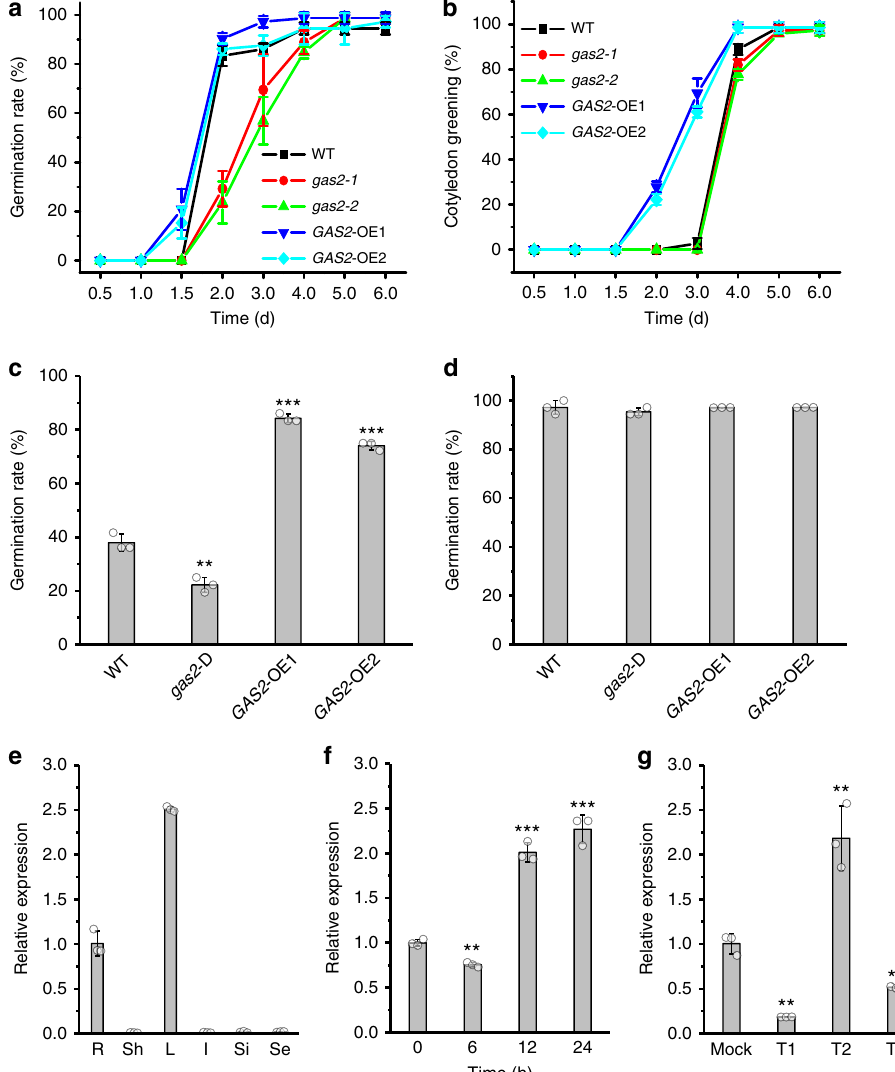
Fig. 2 Silencing and overexpression of GAS2 affects seed germination and cotyledon greening. a , b Seed germination and cotyledon greening analysis of wild-type, gas2-1 , gas2-2 and two GAS2 overexpression lines ( GAS2 -OE1 and OE2) grown on MS. Error bars represent SD (standard deviations) ( n = 72). c , d Germination analysis of wild-type, noninduced gas2 -D and overexpressing GAS2 fresh seeds (not allowed to dry) at the 2-d timepoint after sowing with no strati fi cation ( c ) and strati fi cation (at the 3-d timepoint after sowing) ( d ). Error bars represent SD ( n = 108). ** p < 0.01, *** p < 0.001, t test. e Relative GAS2 mRNA levels in roots (R), shoots (Sh), leaves (L), in fl orescences (I), siliques (Si) and seeds (Se) analyzed by RT-qPCR. Error bars represent SD. f Relative GAS2 mRNA levels in hypocotyls of Arabidopsis after different light/dark treatment (dark 9 d, dark 9 d + light 6 h, dark 9 d + light 12 h and dark 9 d + light 24 h). The dark 9-d level was arbitrarily adjusted to 1 and the remaining levels were normalized to that value. Error bars represent SD. ** p < 0.01, *** p < 0.001, t test. g Relative GAS2 mRNA levels of the seedlings in response to red and far-red light exposure, analyzed by RT-qPCR. Error bars represent SD. ** p < 0.01, t test. Mock: Far red light 0 h; T1: Far red light 2 h; T2: Far red light 2 h + red light 2 h; T3: Far red light 2 h + red light 2 h + Far red light 2